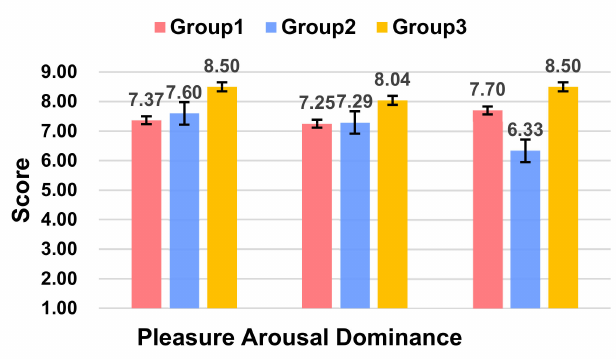
Figure 4. Ratings of Pleasure, Arousal, and Dominance score between the three